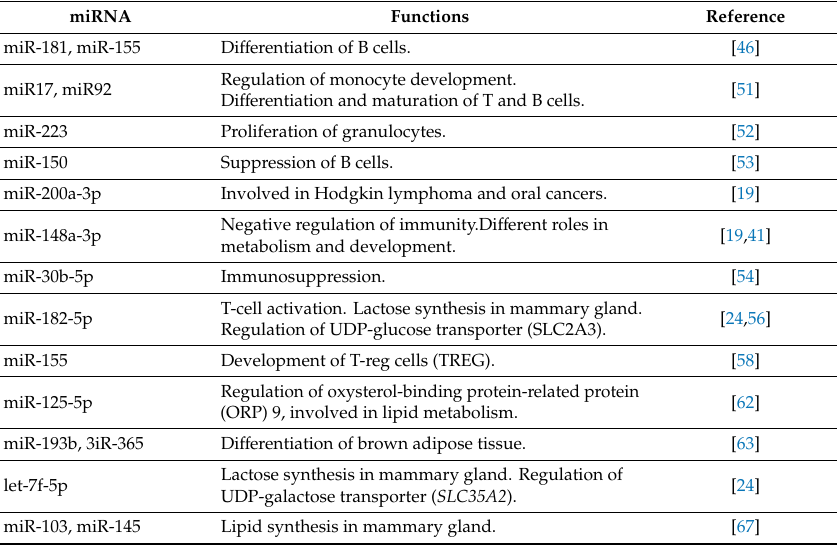
Table 1. Functions of micro RNAs